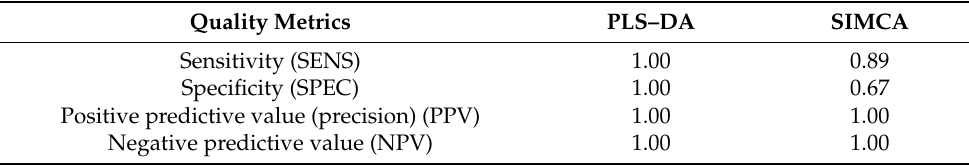
Table 2. Main quality performance metrics (QPM) for PLS-DA and SIMCA